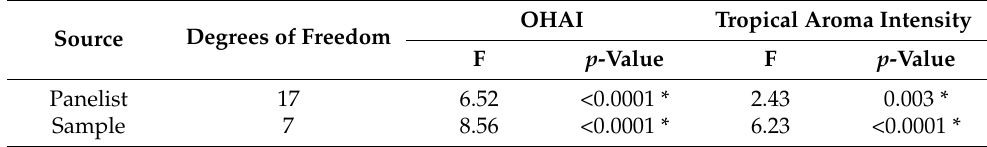
Table 3. Analysis of variance overall hop aroma intensity (OHAI) and tropical aroma